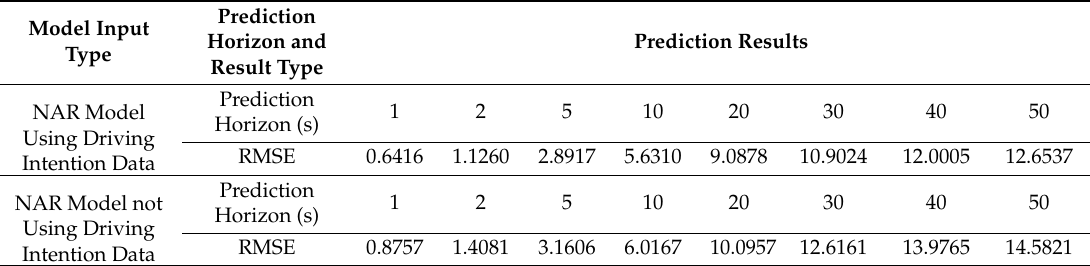
Table 3. Prediction results comparison of NAR neural network at different prediction